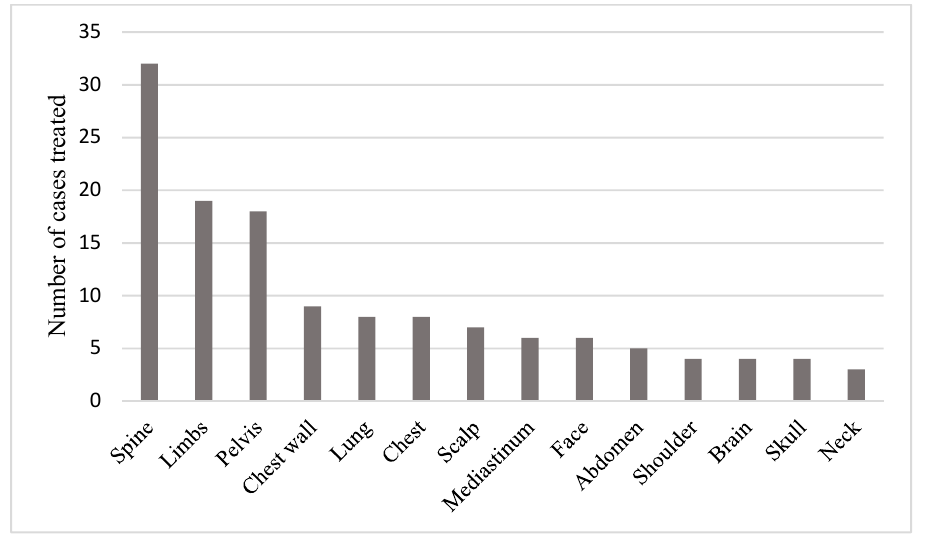
Figure 1. This figure demonstrates the number of cases treated for each histological subtype.